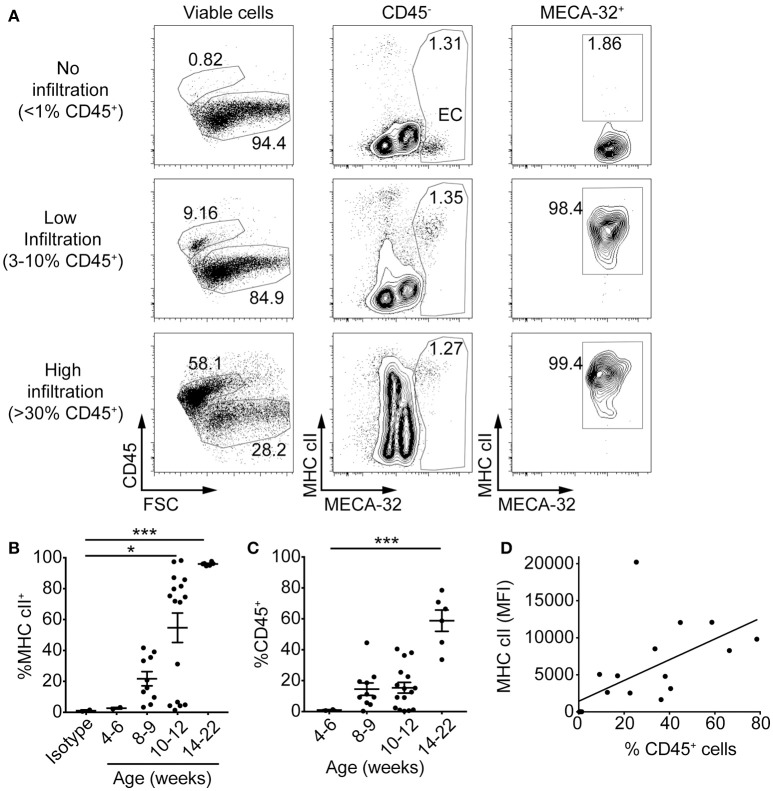
MHC class II on islet endothelial cells is upregulated in the early stages of islet infiltration in NOD mice. Islets were isolated from 4 to 22 week old NOD mice and single cells stained with antibodies to NOD MHC class II, I-Ag7, CD45 for leukocytes, MECA-32 for endothelial cells, and propidium iodide (PI) for viability. (A) Representative plots of MHC class II expression on IEC from NOD islets with no infiltration (upper panel, as determined by < 1% live cells with CD45 staining), low (middle panel, 3–10% live cells CD45+) and high (lower panel, >30% live cells CD45+) levels of infiltration. (B,C) The percentage of (B) MHC class II-positive islet endothelial cells *p = 0.04, ***p = 0.0008 (one-way ANOVA) and, (C) CD45+ cells for NOD mice at different ages ***p < 0.0001 (one-way ANOVA). Data combined from 9 separate experiments, 4–6 weeks (n = 2), 8–9 weeks (n = 10), 10–12 weeks (n = 16), 14–22 weeks (n = 6), mean±SEM. (D) The percentage of CD45+ cells within the islets was plotted against median fluorescence intensity (MFI) of MHC class II on IEC (MECA-32+) for each individual mouse. Data combined from five independent experiments, n = 19, r = 0.6155, r2 = 0.3788, p < 0.01, two-tailed linear regression.